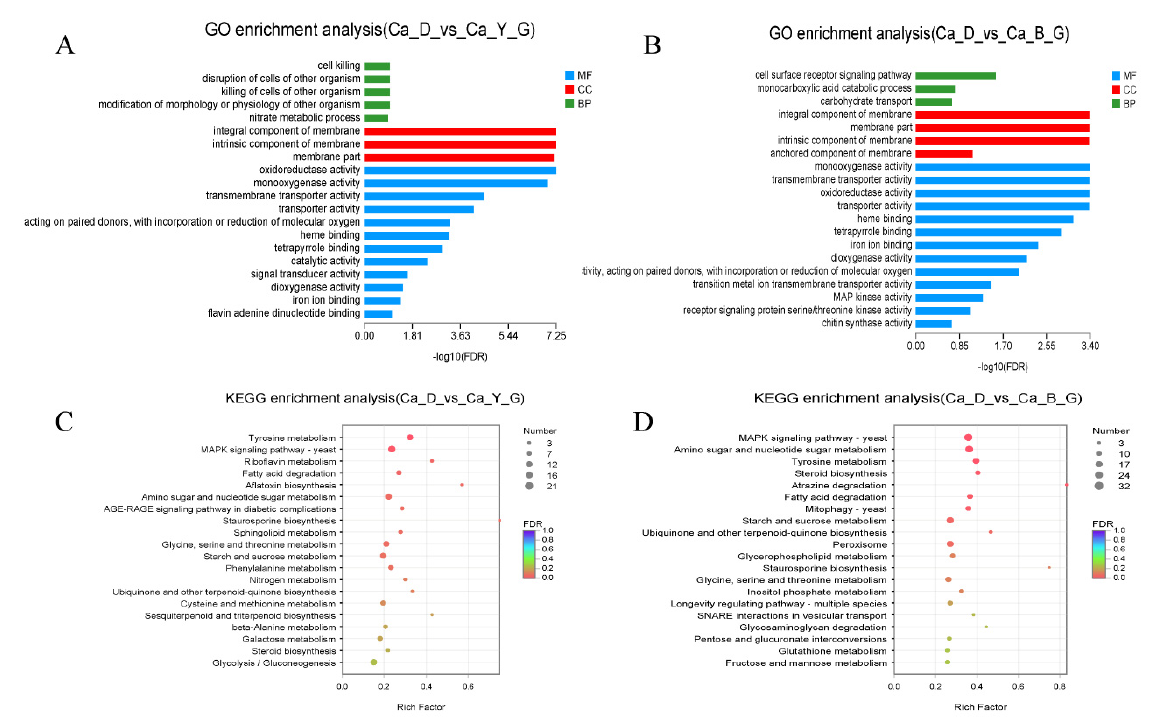
Figure 7. Functional annotation of DEGS in Agaricus sinodeliciosus var. Chaidam ZJU-TP-08 under blue light (B), yellow light (Y), yellow–blue shift (YB) light stimulation. ( A , B ) GO annotation analysis of DEGs from Ca-D vs. Ca-Y and Ca-D vs. Ca-B group. The vertical axis represents GO term, the horizontal axis represents the significance level of enrichment, and the three colors represent three categories, namely biological process (BP), cell component (CC), and molecular function (MF). ( C , D ) The top 20 KEGG annotation pathways from Ca-D vs. Ca-Y and Ca-D vs. Ca-B group. The vertical axis represents the KEGG pathway, and the abscess axis represents the significant level of enrichment. Different colors represent three branches of KEGG metabolic pathway, namely metabolism (M), environmental information processing (EIP), cellular process (CP).